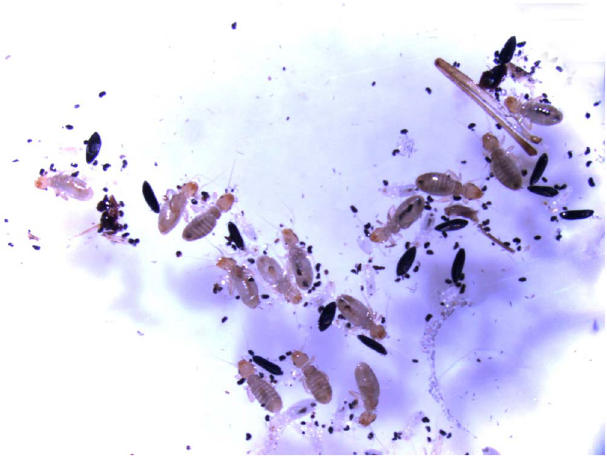
Figure 3. Treatment papers with heavy infestation (31 individual psocids and 14 intact eggs within the fi eld of view). Photo by M.